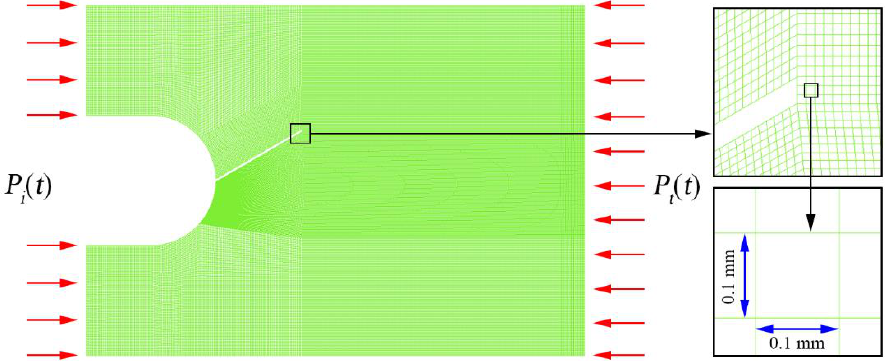
Figure 11. Numerical (AUTODYN) model of the specimen-30°.